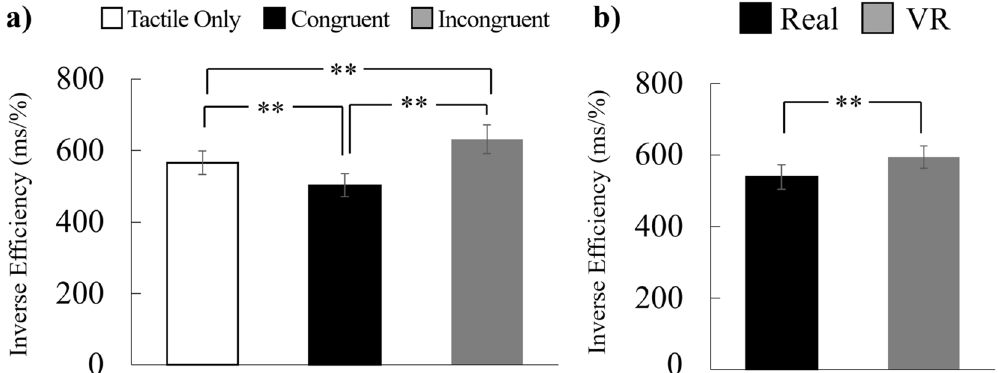
Figure 5. Averaged inverse efficiency (IE) of the tactile detection task on either the index or ring finger. ( a ) Averaged IE values for each stimulus combination and item, merged across environments. ( b ) Averaged IE values for each environment and item, merged across stimulus combinations. Participants responded with the finger that was stimulated. “Real” and “VR” indicate results in real and VR environments, respectively. “Tactile only” represents a score given after only tactile stimulations as baseline on tactile detection task. “Congruent” and “Incongruent” represent scores given after stimulations done under congruent and incongruent conditions, respectively. ** p <